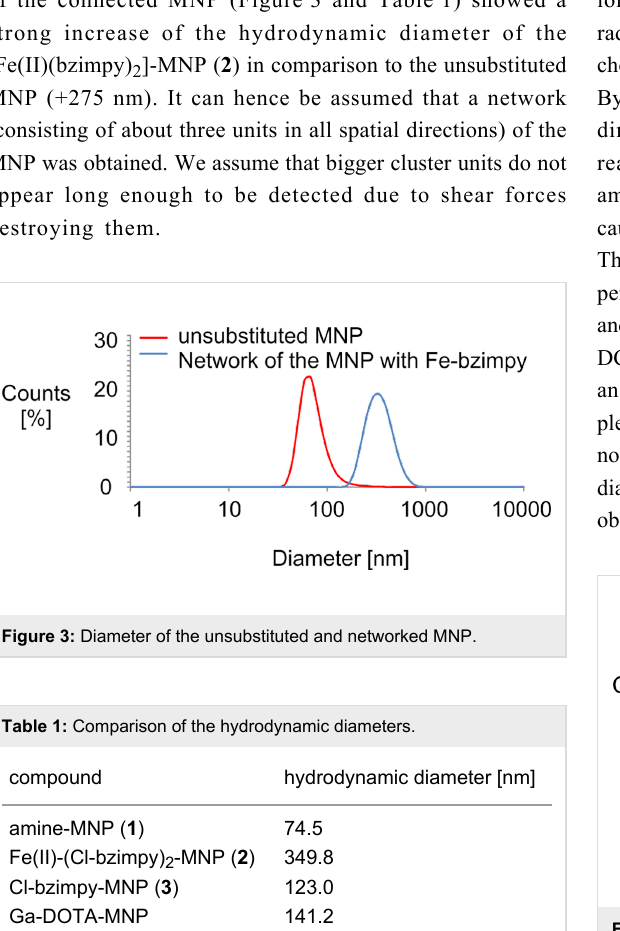
Figure 4: Diameter of the synthesized